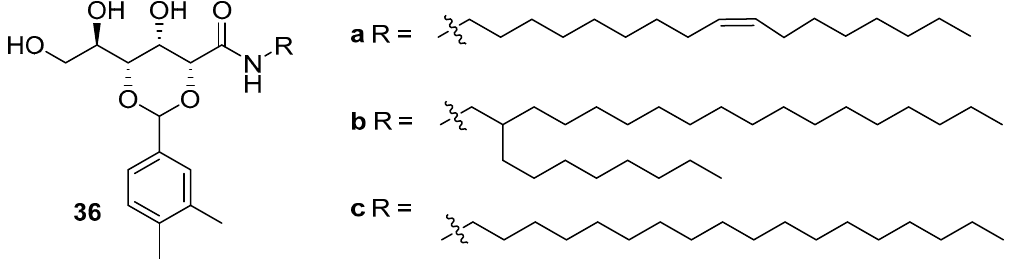
Figure 26. Chemical structures of other reported D-gluconic acetal based gelators [72].